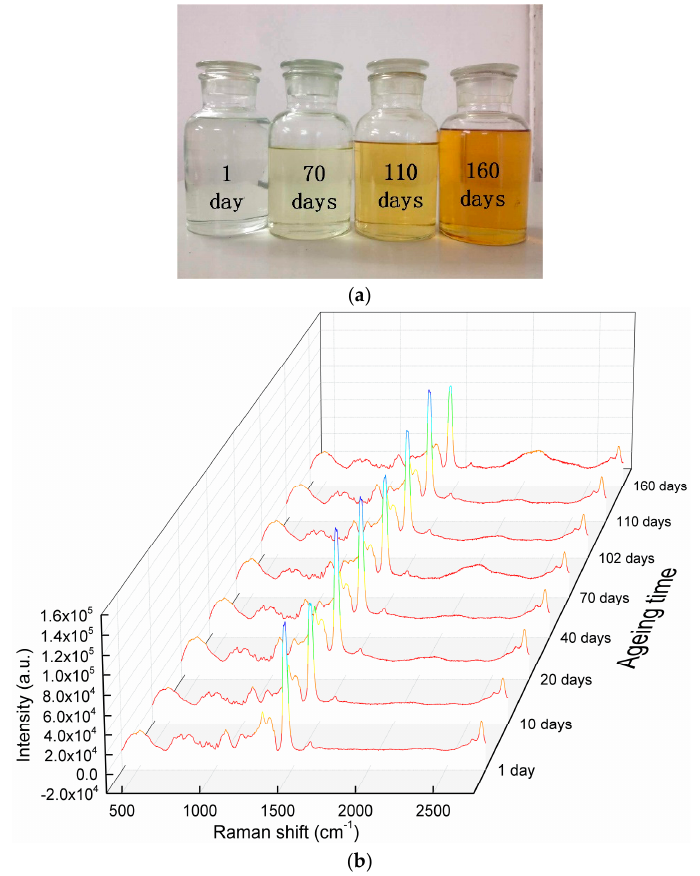
Figure 3. Oil samples and the shape of Raman spectra: ( a ) Four oil samples collected at different aging times; ( b ) Raw Raman spectra of the insulation oil samples for different aging times.